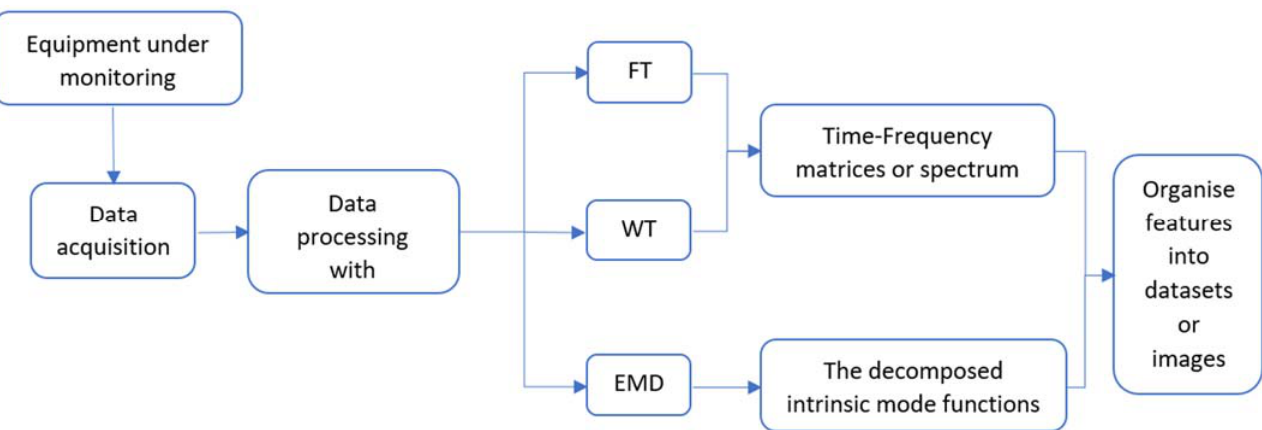
Figure 2. Flow chart of feature extraction